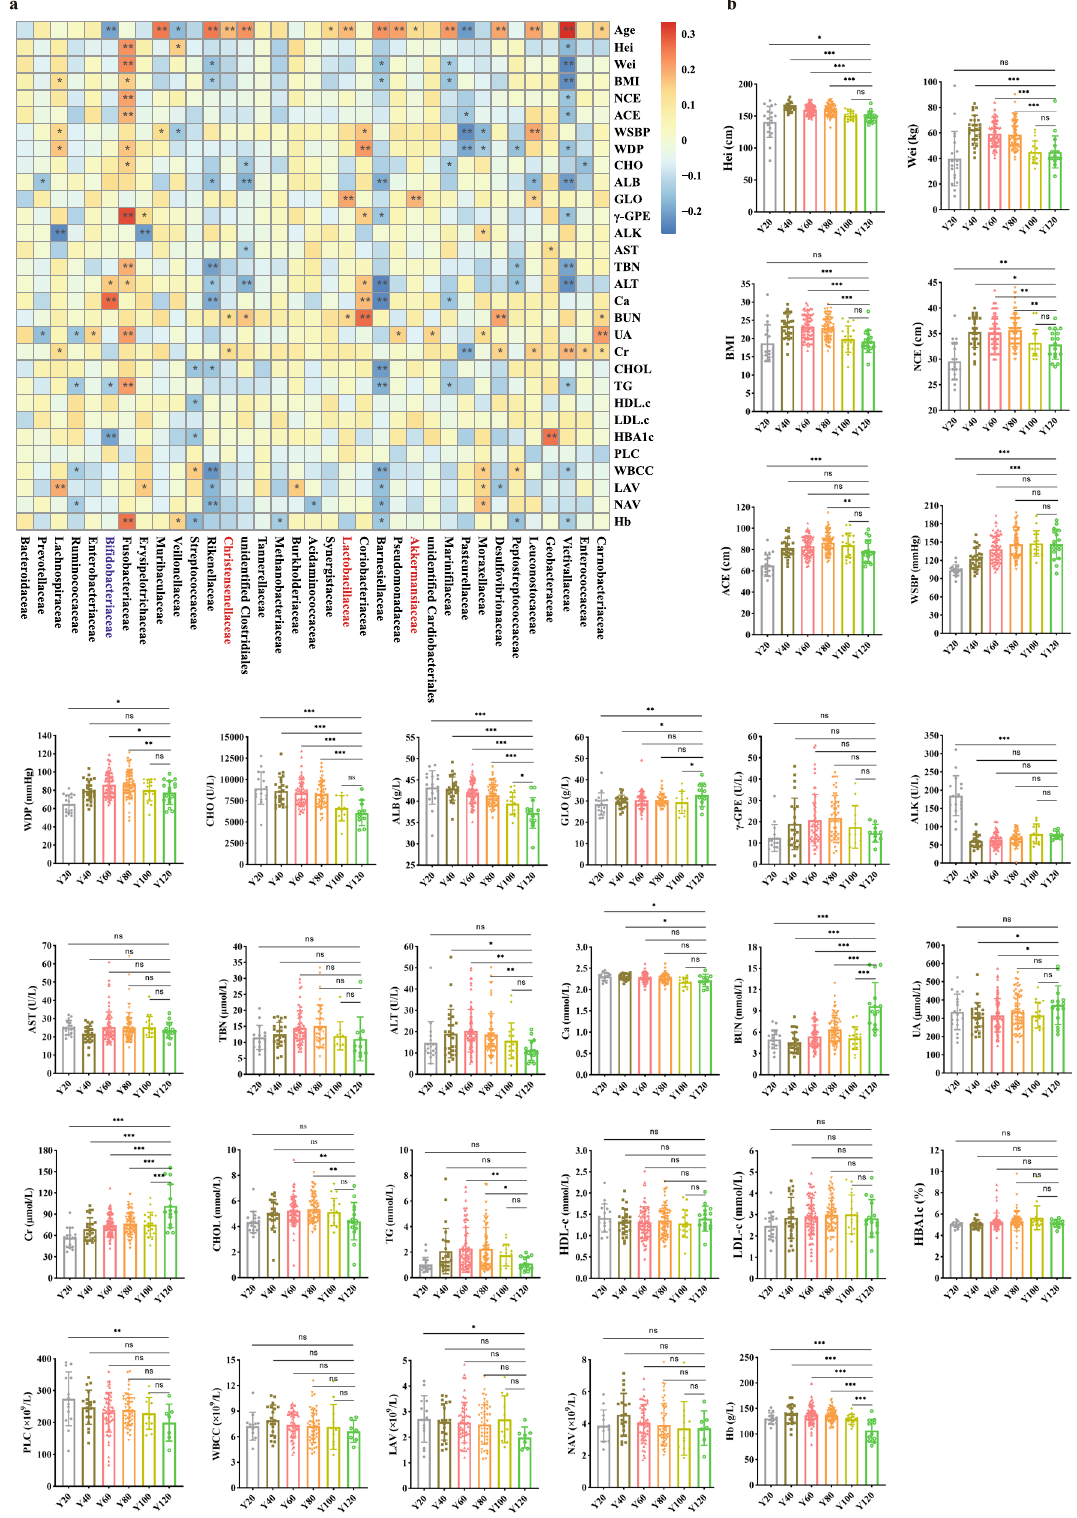
NAD(P)/FAD-dependent oxidoreductase (EC:1.6.99.3, ko00190 Oxida- tive phosphorylation), gpx : Glutathione peroxidase (EC:1.11.1.9, ko00480 Glutathione metabolism; ko00590 Arachidonic acid metabo- lism; ko04918 Thyroid hormone synthesis), trxA : Thioredoxin (ko04621 NOD-like receptor signaling pathway; ko05418 Fluid shear stress